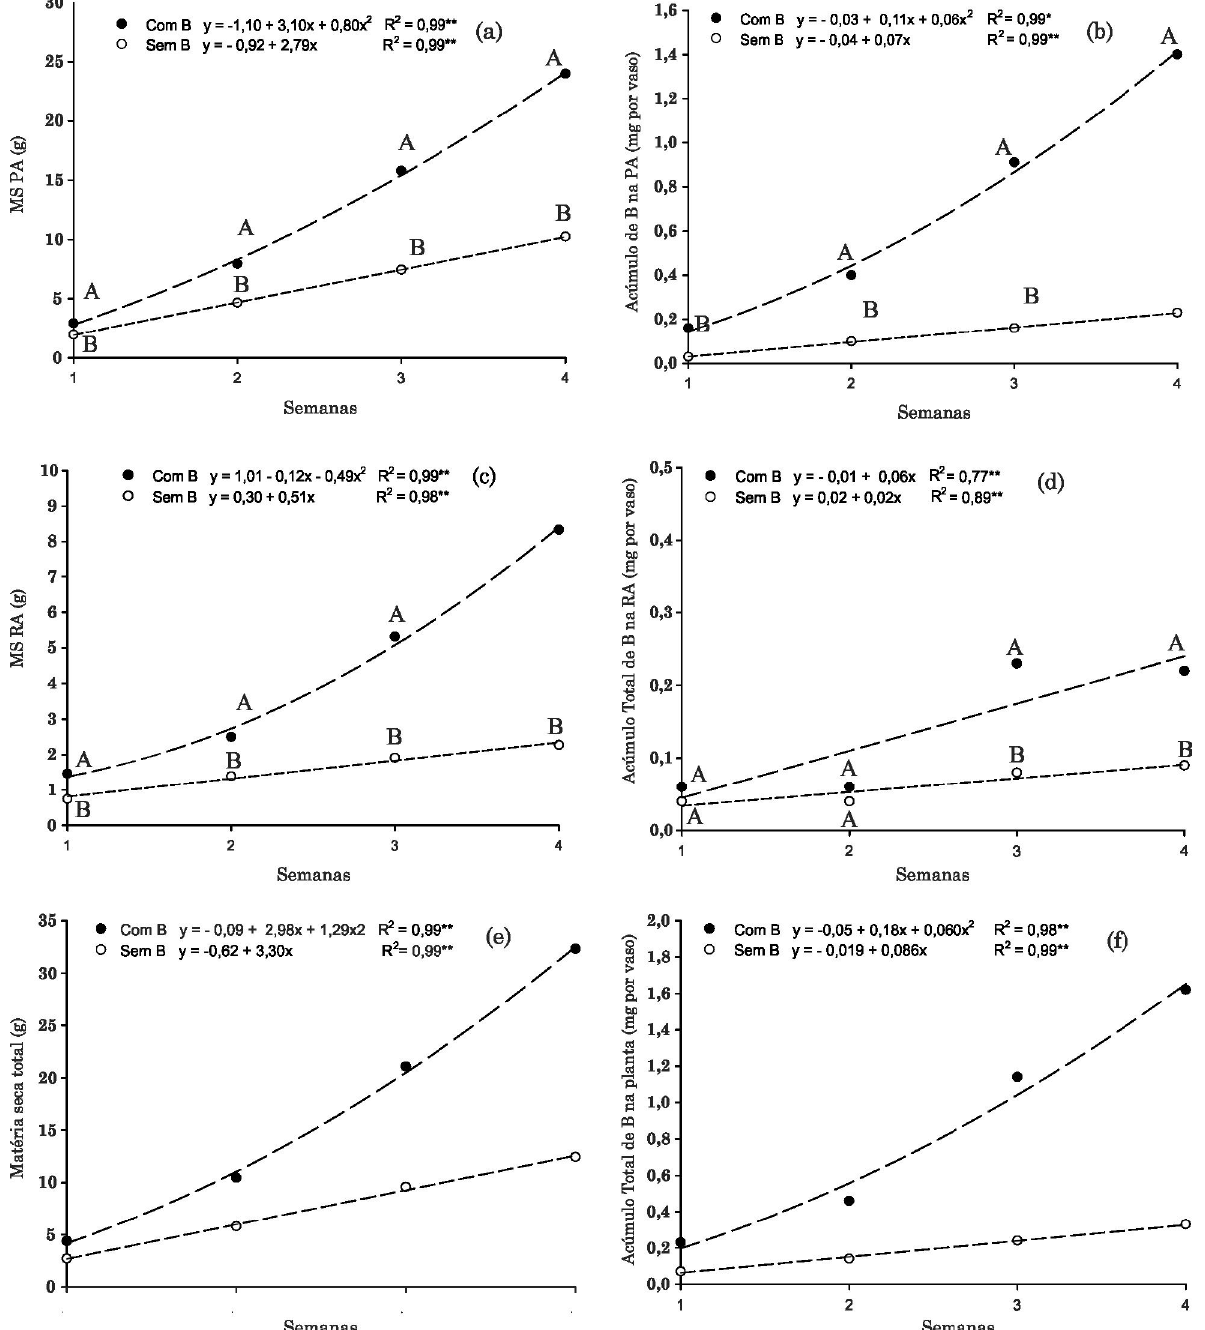
Figura 1. Matéria seca da parte aérea (a), acúmulo de boro na parte aérea (b), matéria seca da raiz (c), acúmulo de boro da raiz (d), matéria seca total (e) e acúmulo total de boro na planta (f) em algodoeiro, em função do tempo e da adição de B à solução nutritiva (média de quatro cultivares). * e ** indicam significância (p<0,05 e p<0,01, respectivamente). Letras distintas indicam diferença significativa entre doses, dentro de cada semana (p<0,05). Os gráficos estão apresentados em escalas